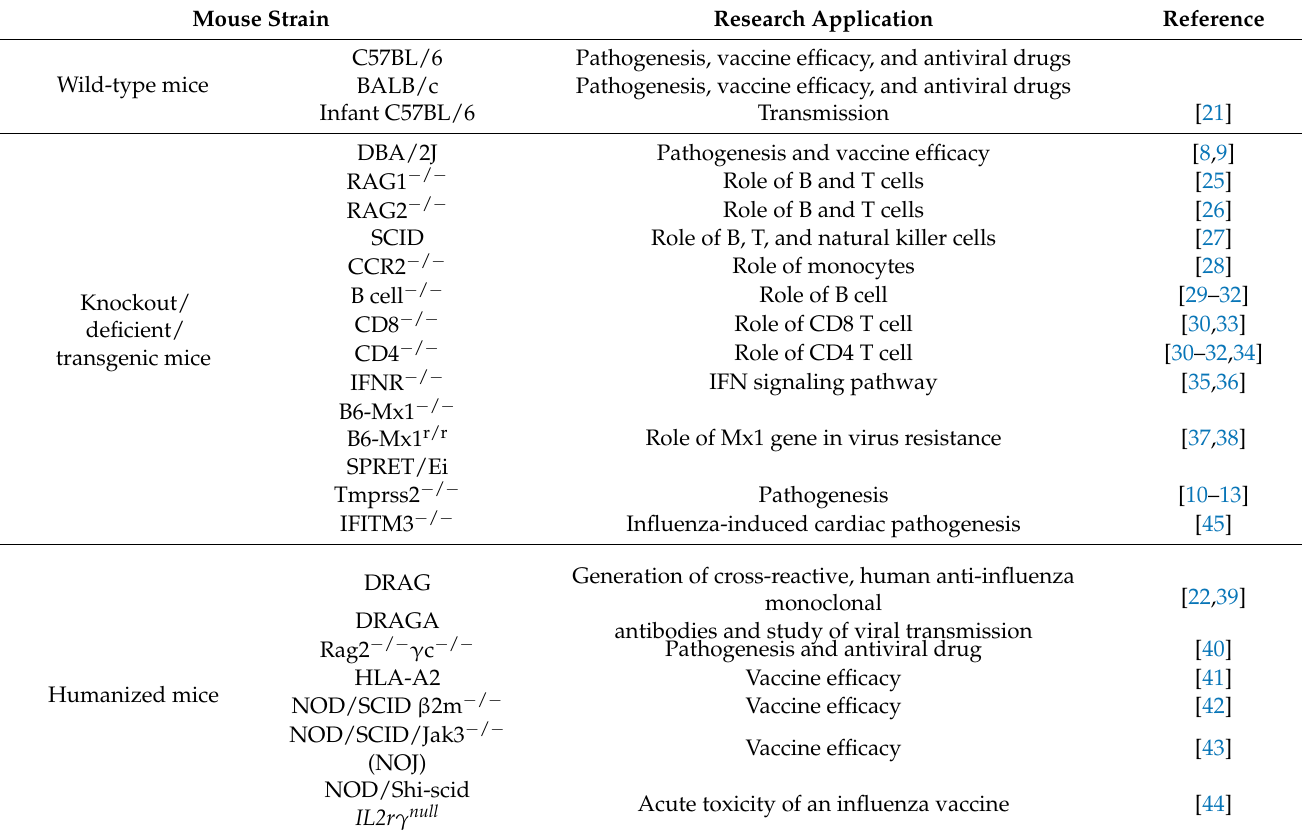
Table 1. Mouse strains used in influenza virus